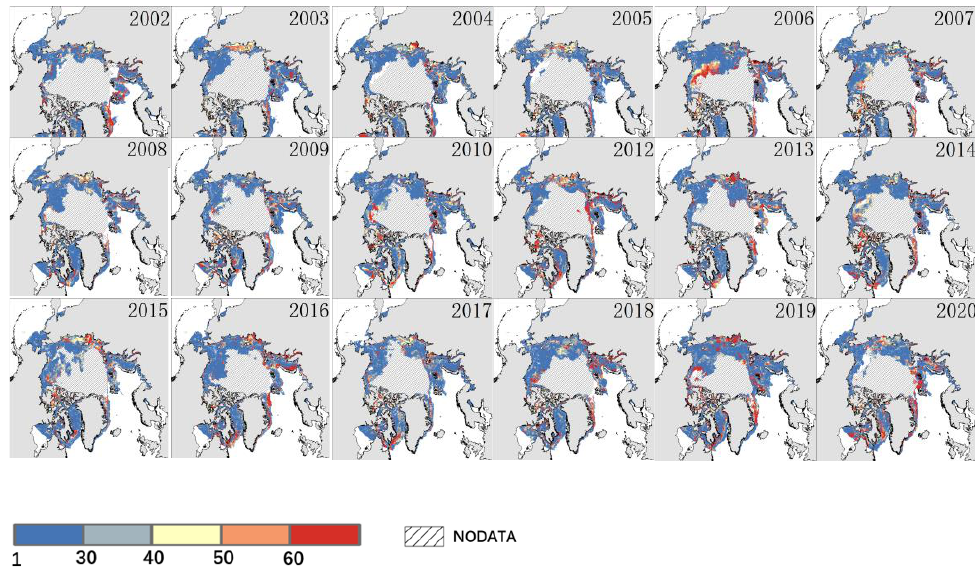
Figure 12. Number of days from breaking up to complete melting of Arctic sea ice, 2002 – 2020. Table 8. Days from breaking up to complete melting of Arctic sea ice,